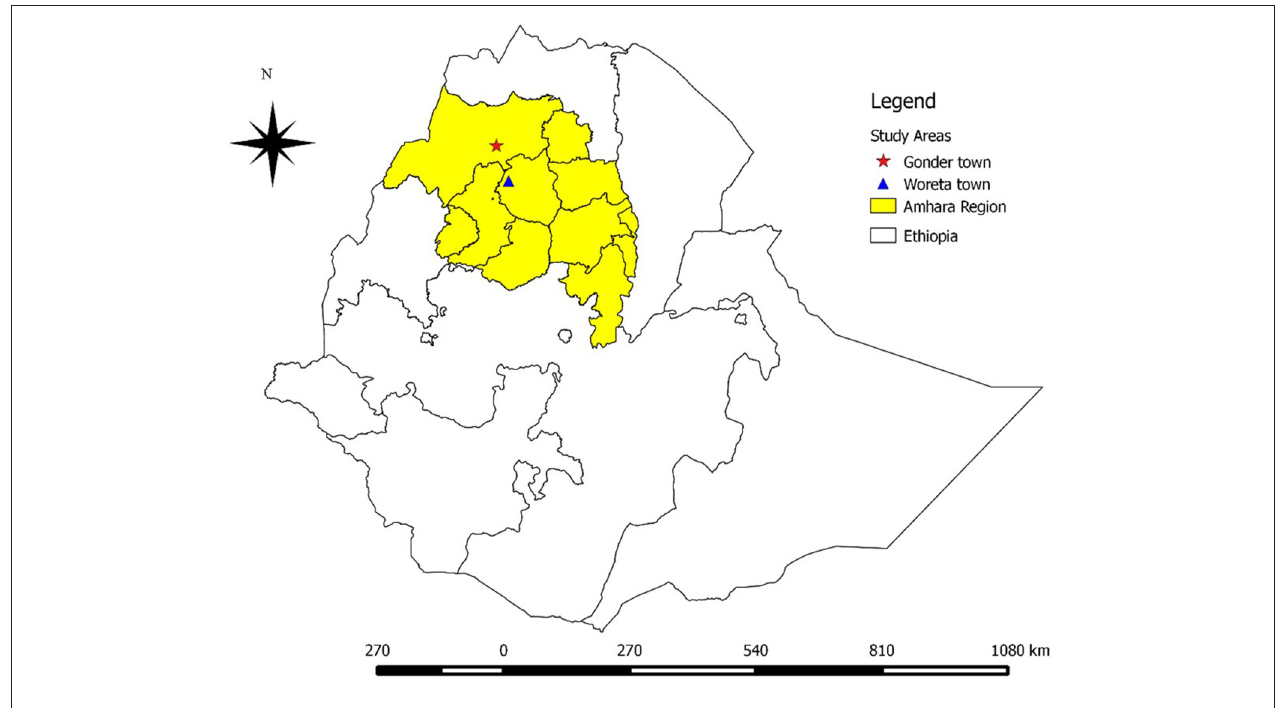
FIGURE 1 | Map of study